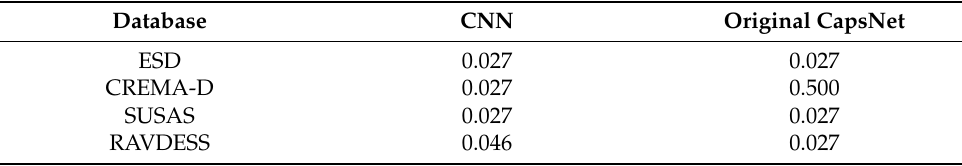
Table 10. p -Values Between the proposed model, CNN, and original CapsNet.